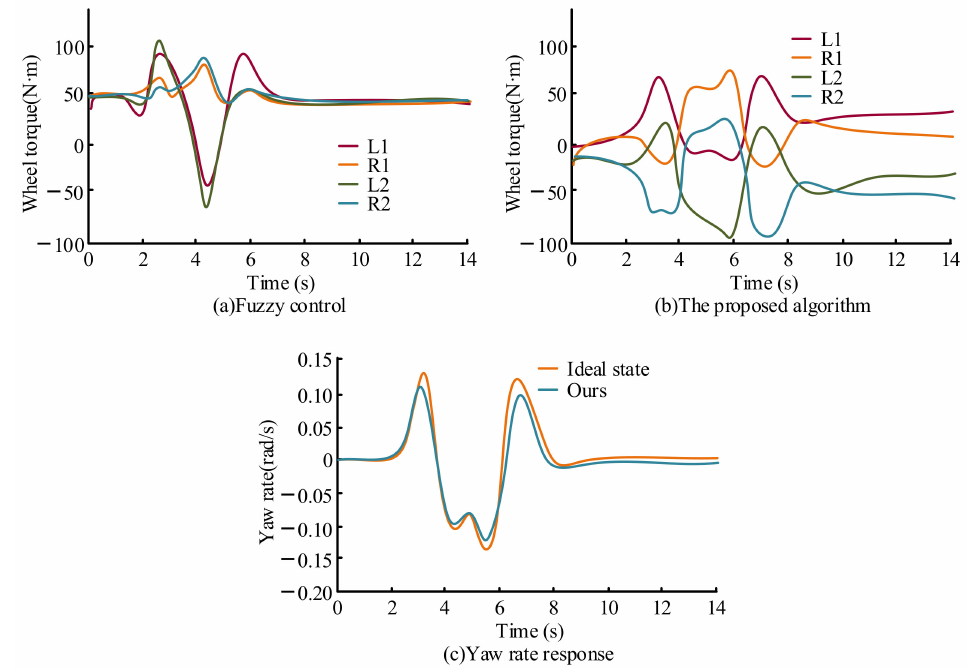
Figure 9. Variation of wheel torque and yaw rate under double line shifting condition.